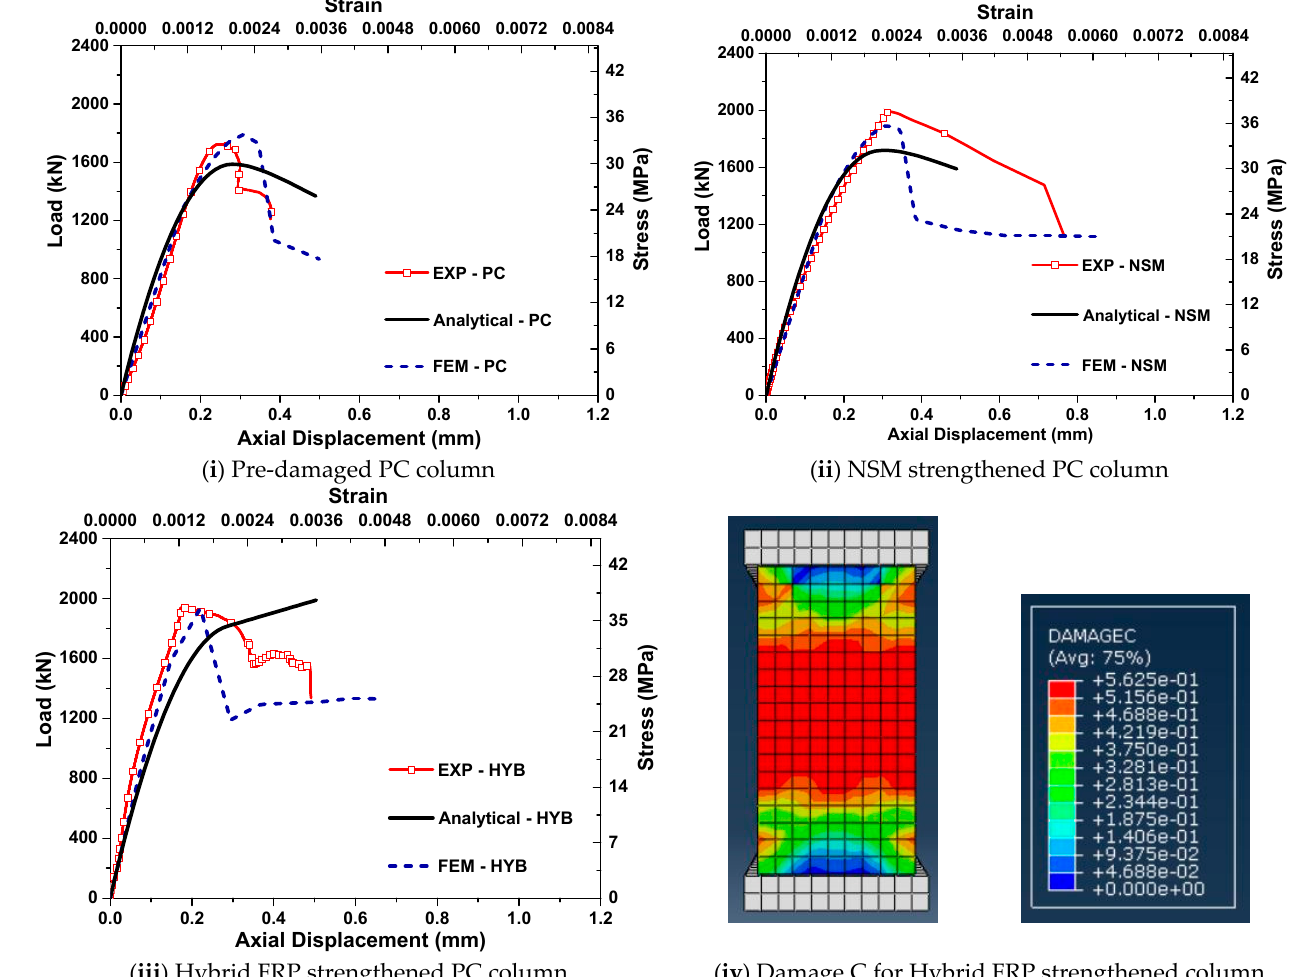
Figure 12. Comparison of pre-damaged PC columns under axial compression.